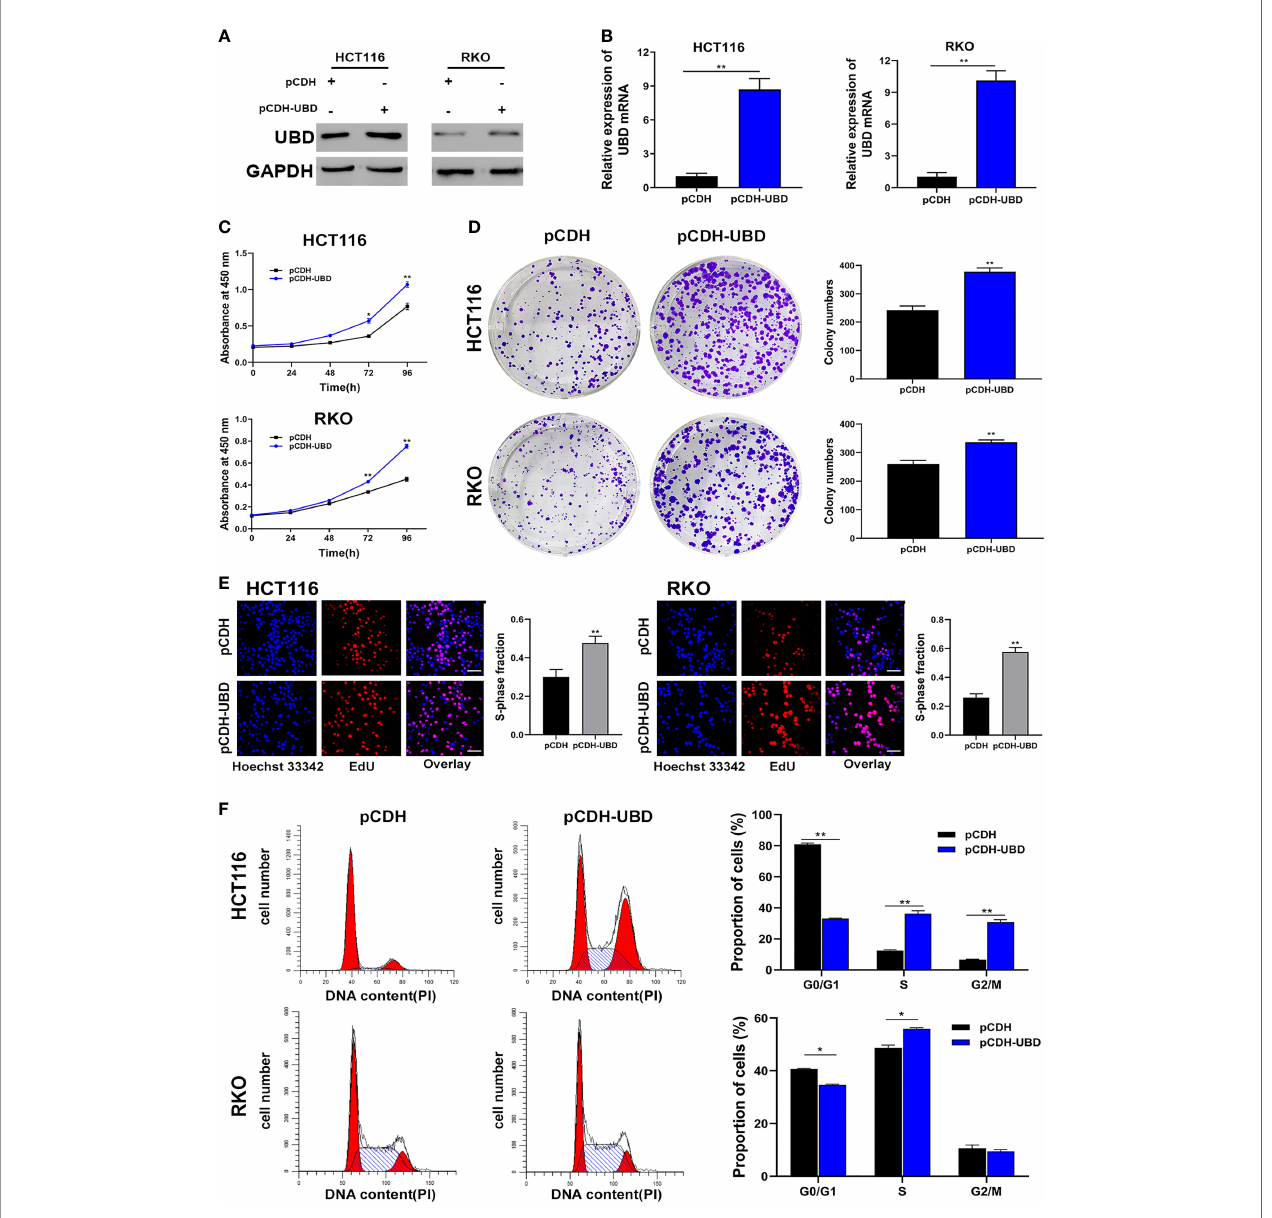
FIGURE 3 | Upregulated expression of UBD promotes the CRC cell proliferation and cycle progression in vitro . (A, B) Western blot (A) and qRT-PCR (B) analyses of UBD protein and mRNA levels in CRC cells after UBD overexpression (** p < 0.01). (C) CCK-8 assay was used to analyze the cell viability of UBD stable overexpressed HCT116 and RKO cells (* p < 0.05; ** p < 0.01). (D, E) The effect of UBD overexpression on the growth of HCT116 and RKO cells compared with negative control were analyzed by colony formation assays (D) and EdU assay (E) , magni fi cation, 400×; scale bar, 100 m m). Quantitative results of colony numbers and EdU positive cells are presented in data graphs (** p < 0.01). (F) Flow cytometry assays were performed to analyze cell cycle in HCT116 and RKO UBD stable overexpression cell lines (* p < 0.05; ** p <